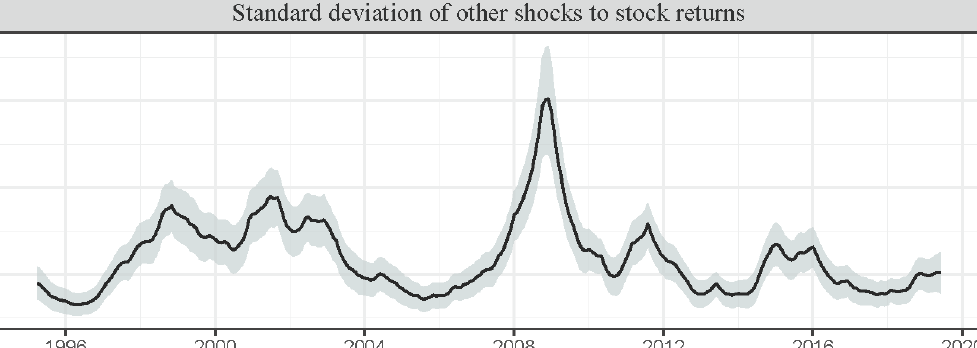
Figure A3. Standard deviations of structural shocks. Note: This figure presents the posterior means and the credible intervals of standard deviations of structural shocks (1995:04–2019:06). The solid black line shows the mean while the gray area displays the 16th and 84th percentiles.